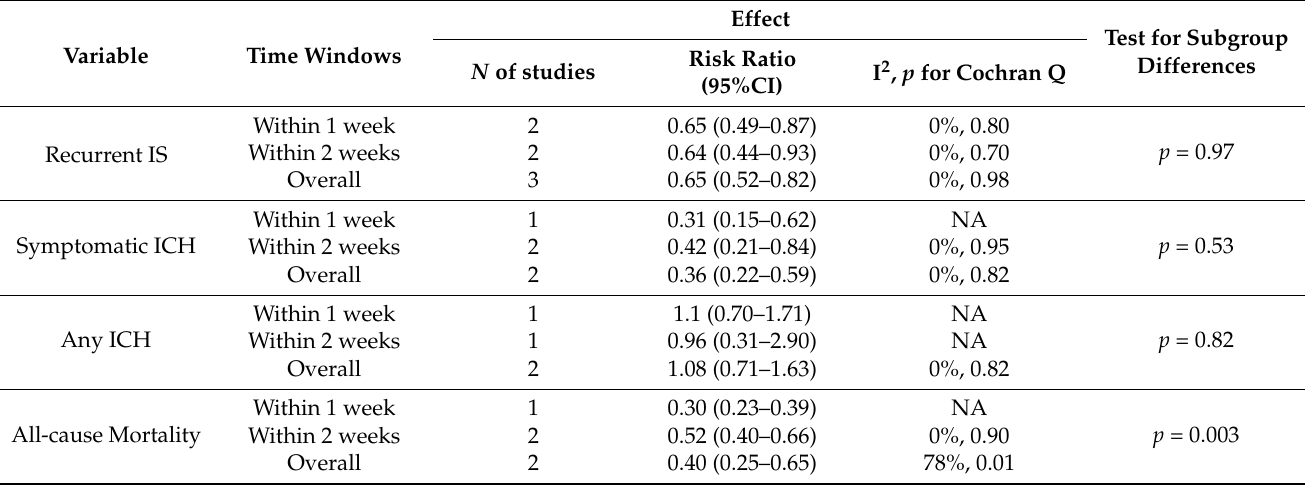
Table 3. Overview of the primary outcomes of the two-arm analysis comparing DOAC versus VKA in patients on early anticoagulation, stratified by the treatment